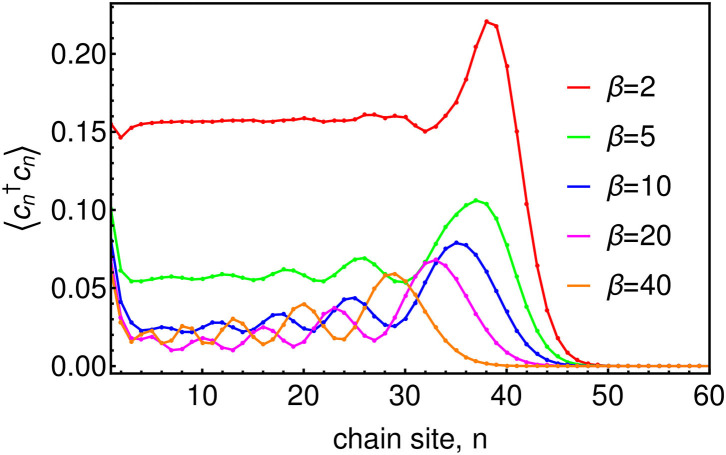
Chain mode occupations 〈cn†cn〉 at time ωct = 45 for baths of several temperatures. The system, which in this case is the Ohmic SBM, with ω0 = 0.2ωc and α = 0.1, is attached at site n = 1 of the chain.